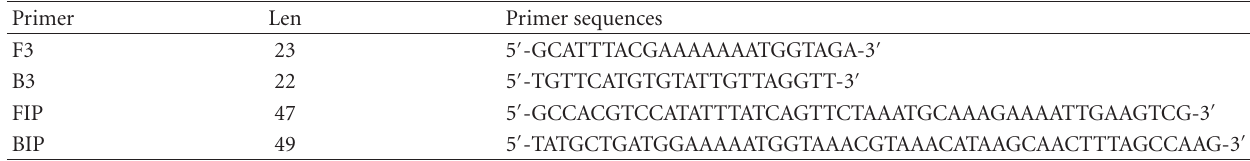
Table 1: Primer sequences for LAMP.